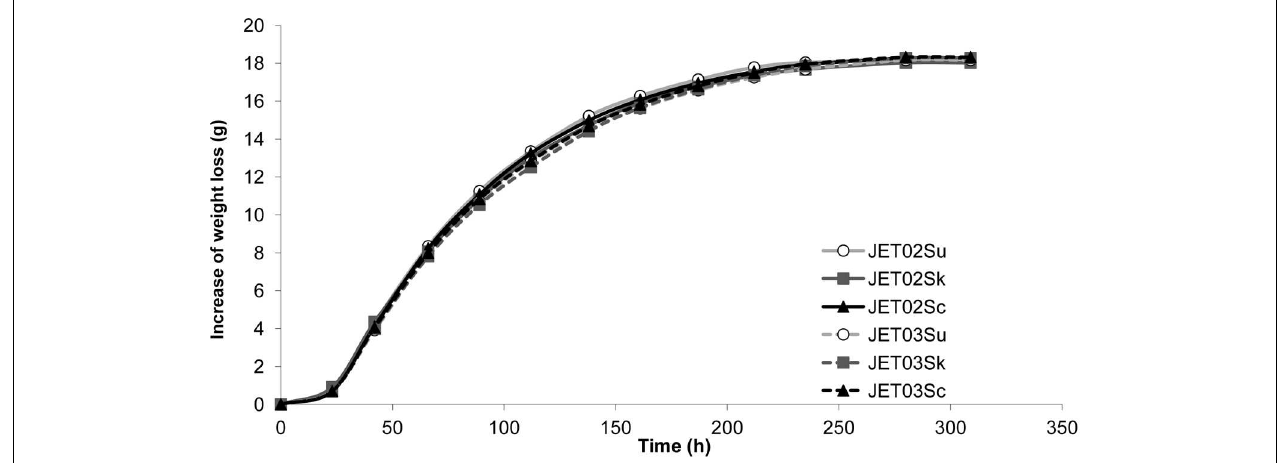
FIGURE 1 | Progress of synthetic wine must fermentation. Fermentations were monitored by weight loss until a constant weight was achieved.